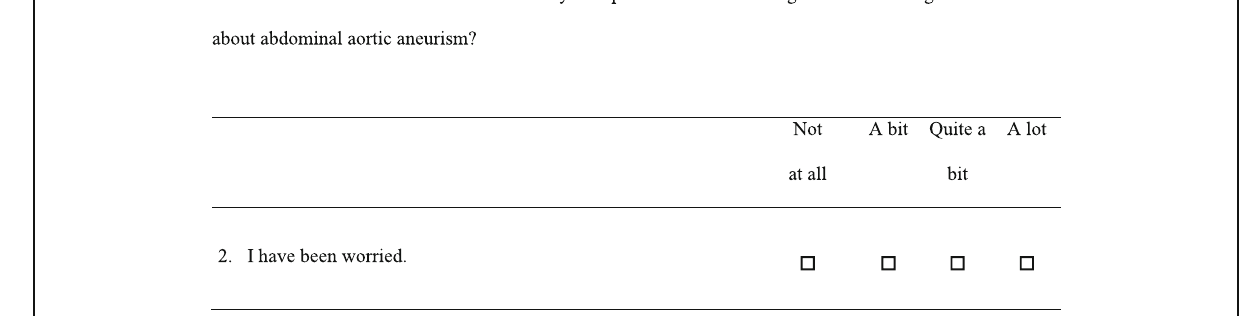
Fig. 1 The layout and response categories for part I of the Consequences of Screening questionnaire